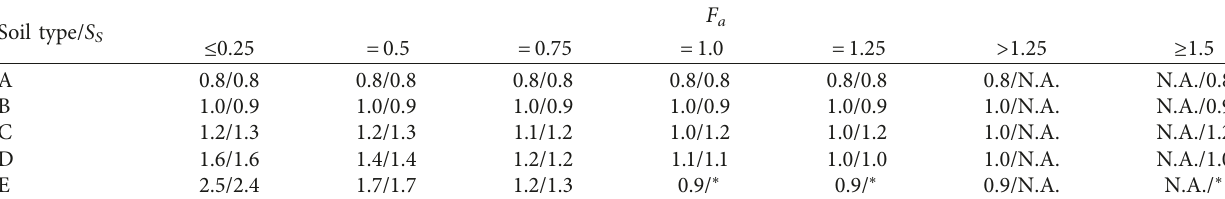
Table 9: Site effects (the USA) in the short period range [12,22].